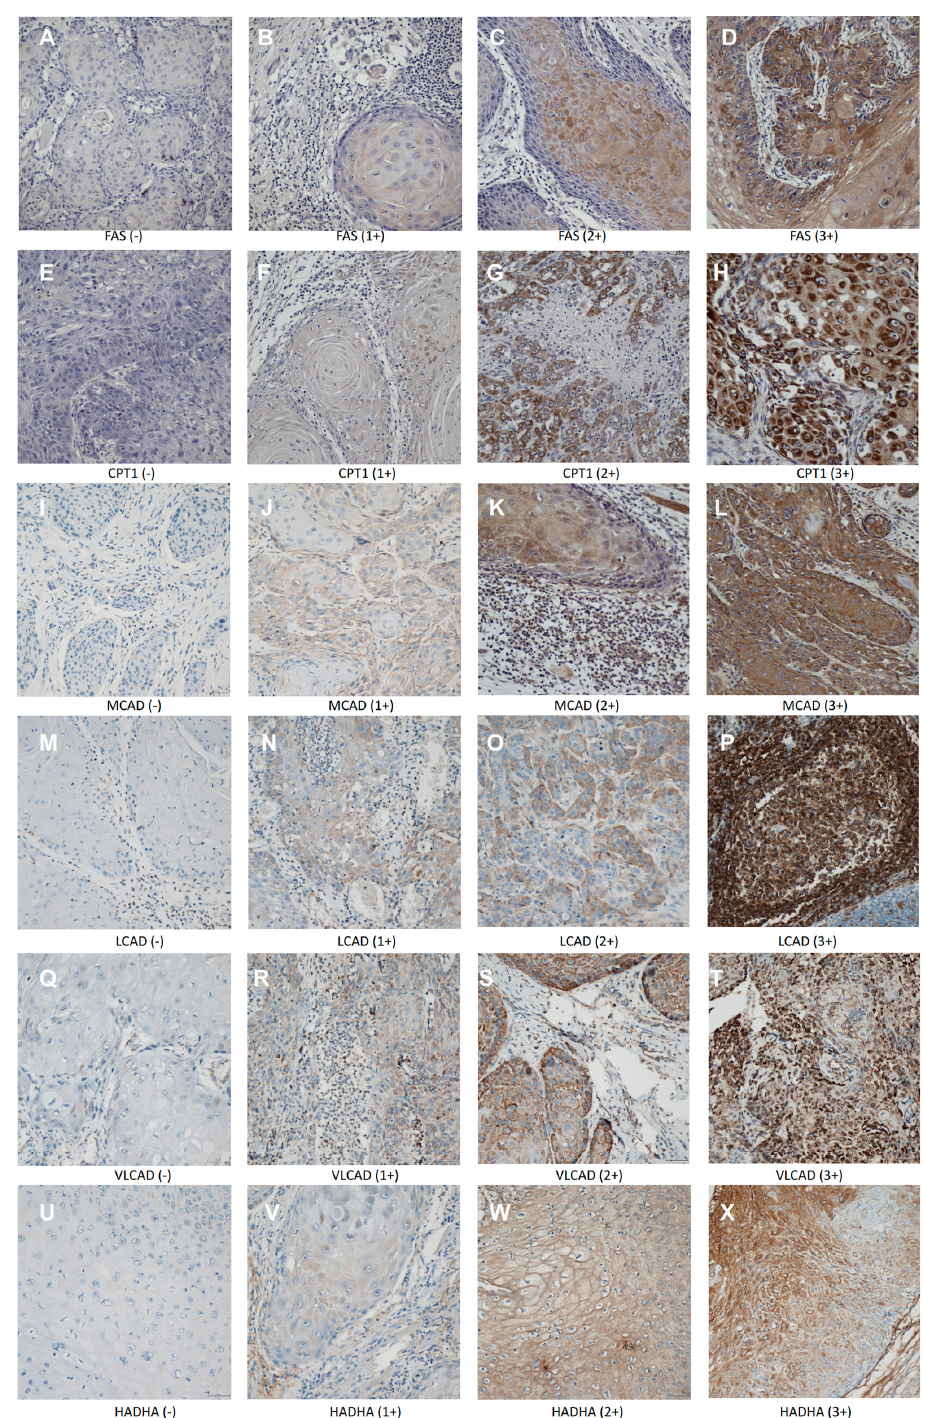
Figure 1. Representative immunohistochemical staining scores of antibodies used in the specimens of squamous cell carcinoma of the head and neck. All proteins were predominantly expressed in the cytoplasm of tumor cells. ( A – D ) fatty acid synthase (FAS) staining (0 to 3 + ), ( D – H ) carnitine palmitoyltransferase 1 (CPT1) staining (0 to 3 + ), ( I – L ) medium-chain acyl-CoA dehydrogenase (MCAD) staining (0 to 3 + ), ( M – P ) long-chain acyl-CoA dehydrogenase (LCAD) staining (0 to 3 + ), ( Q – T ) very-long-chain acyl-CoA dehydrogenase (VLCAD) staining (0 to 3 + ), and ( U – X ) hydroxyacyl-CoA dehydrogenase / 3-ketoacyl-CoA thiolase / enoyl-CoA hydratase (HADHA) staining (0 to 3 + ), (magnification 200 ×